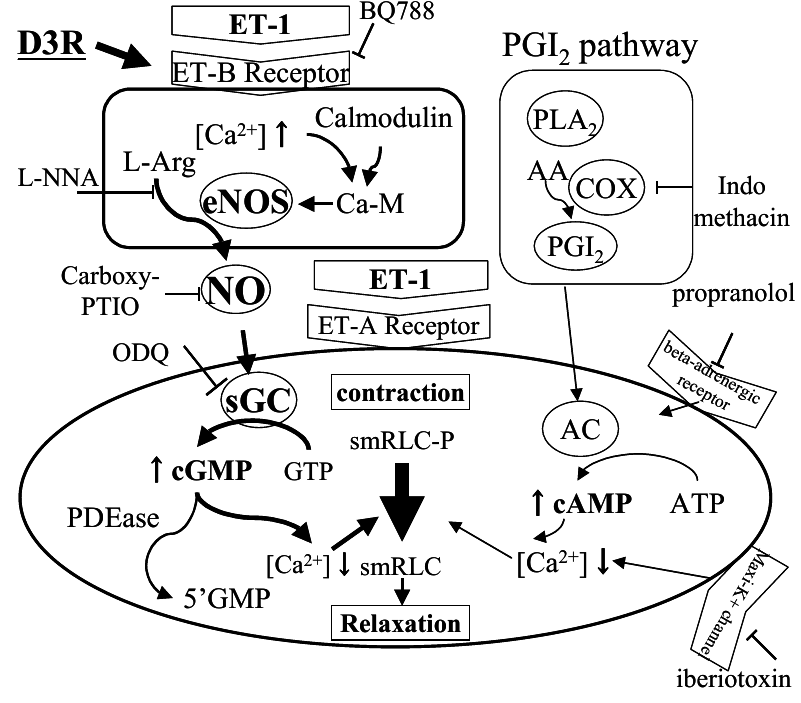
Figure 7. Schematic diagram of relaxation induced by D3R.